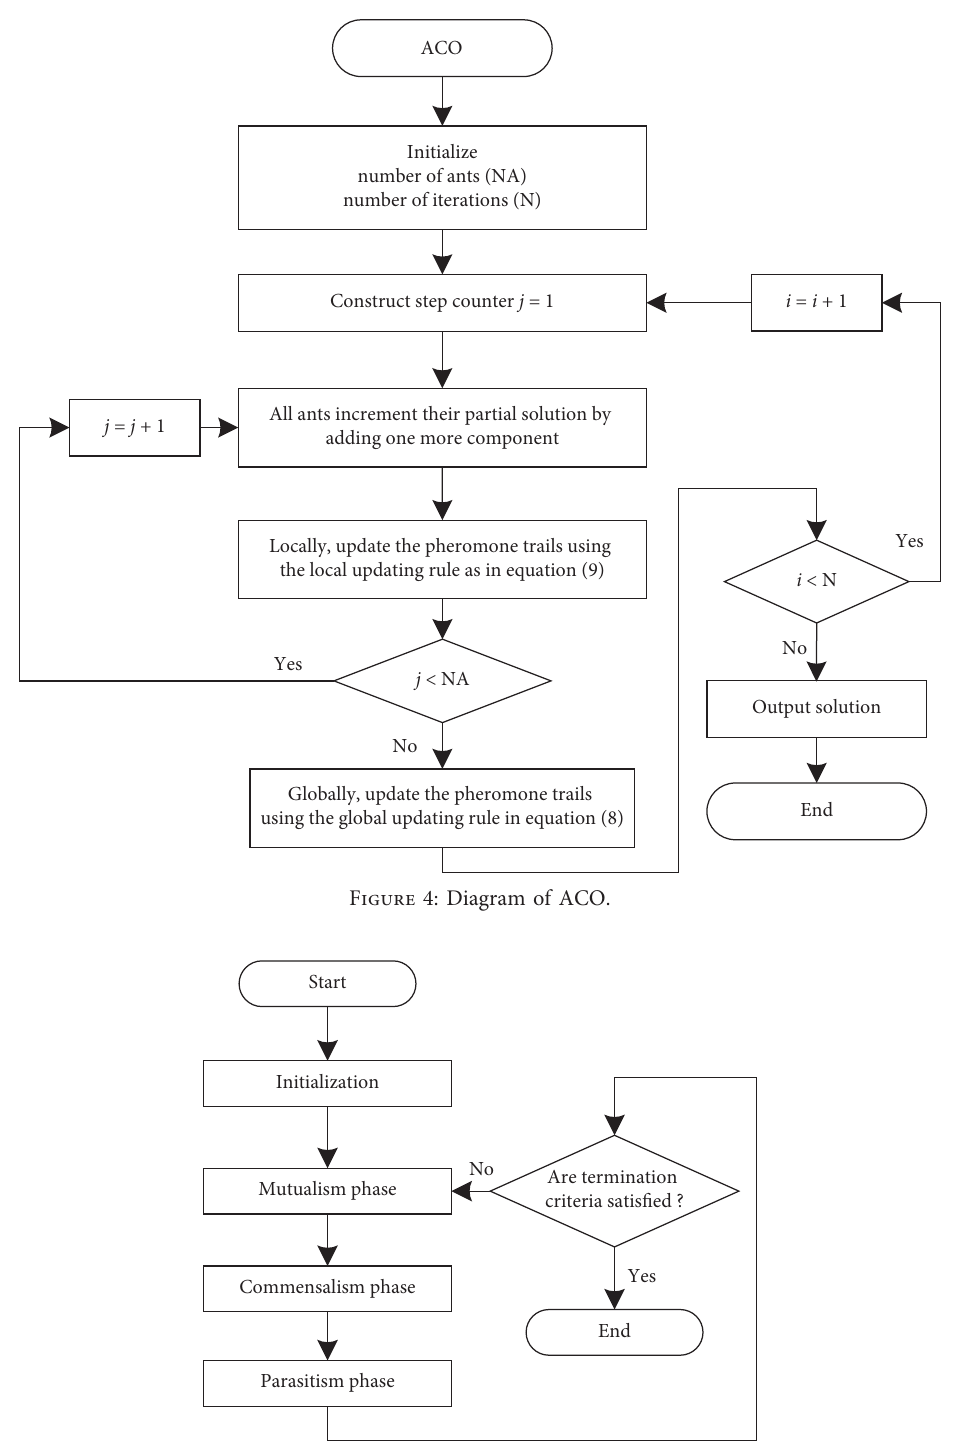
Figure 5: Diagram of SOS.